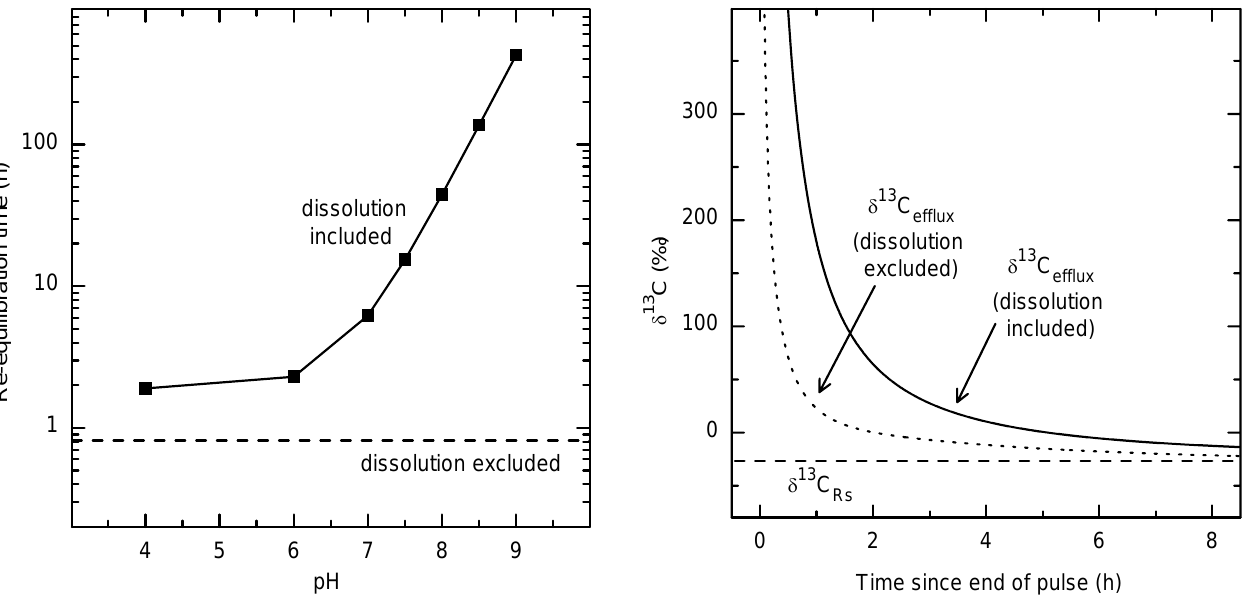
Fig. 9. Modelled δ 13 C efflux following pulse labelling with highly enriched CO 2 (20atom% 13 CO 2 ) for 1h. Dissolution of CO 2 in soil water was included (solid line) or excluded (dotted line) in the CO 2 transport model. δ 13 C Rs was kept constant at − 26 . 7‰ (dashed